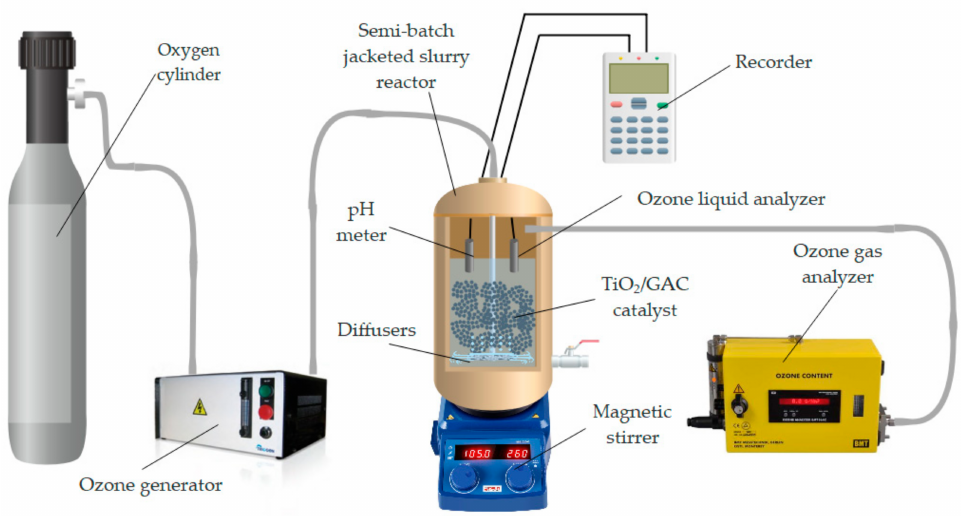
Figure 1. Experimental set-up used to carry out catalytic ozonation